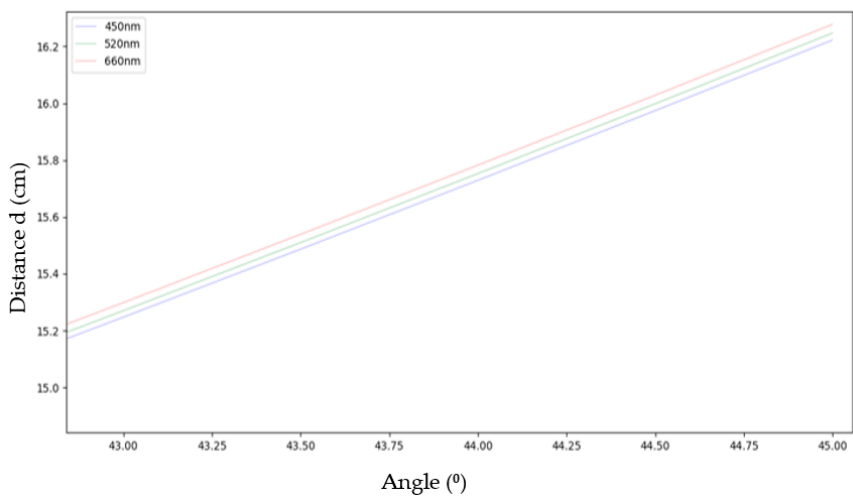
Figure 8. Effect of wavelength on the distance d of pure water sample for different angle of incidence ◦ C and W 𝜃 (cid:3036) at T = 30 °C and 𝑊 (cid:3050)(cid:3028)(cid:3047)(cid:3032)(cid:3045) = 5 cm . θ water = 5 cm. i at T = 30